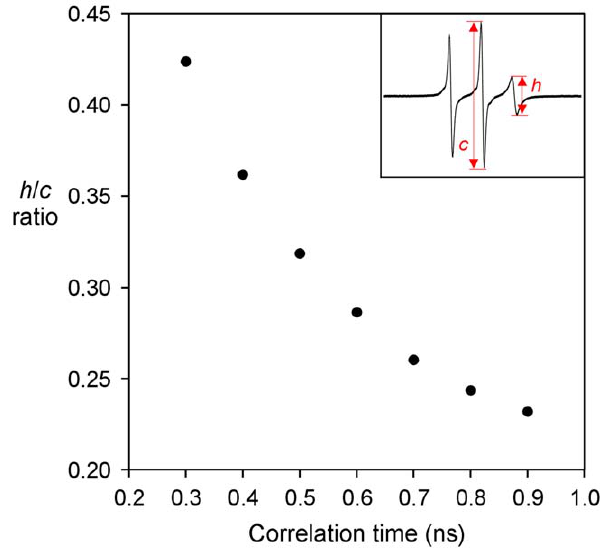
Figure 3. Plot of the h/c ratio as a function of correlation time in the range of 0.3–0.9 ns based on simulated EPR spectra. The measurements of the center and high-field line amplitude are shown in the inset. Note that the h/c ratio changes significantly as a function of correlation time in the sub-nanosecond range, and thus providing a sensitive measure of spin label